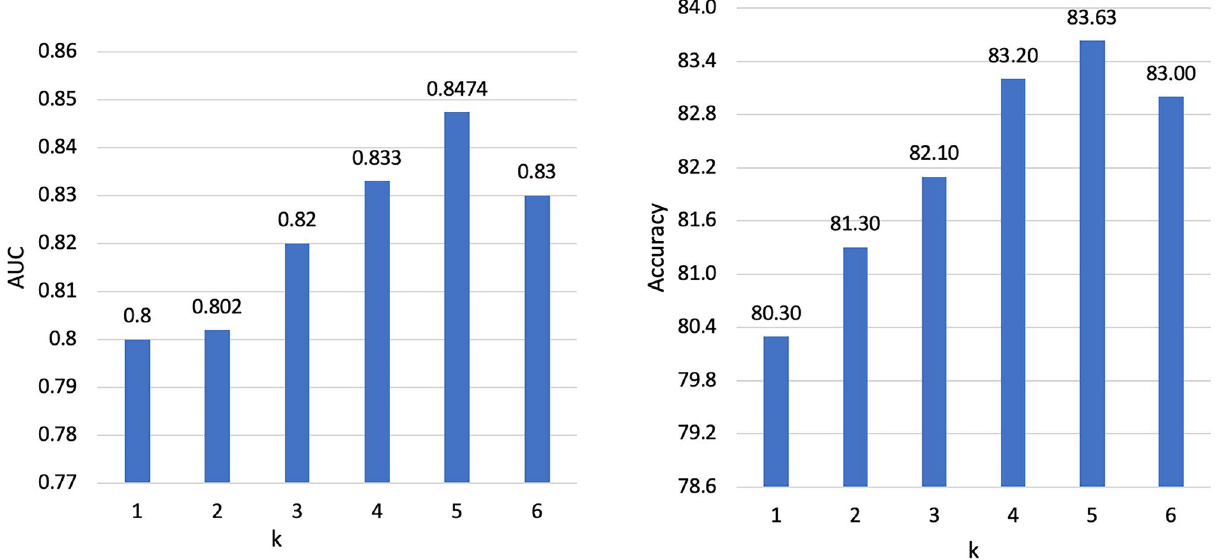
Figure 5. The data labelling performance with varying number of bootstrapping samples (k).